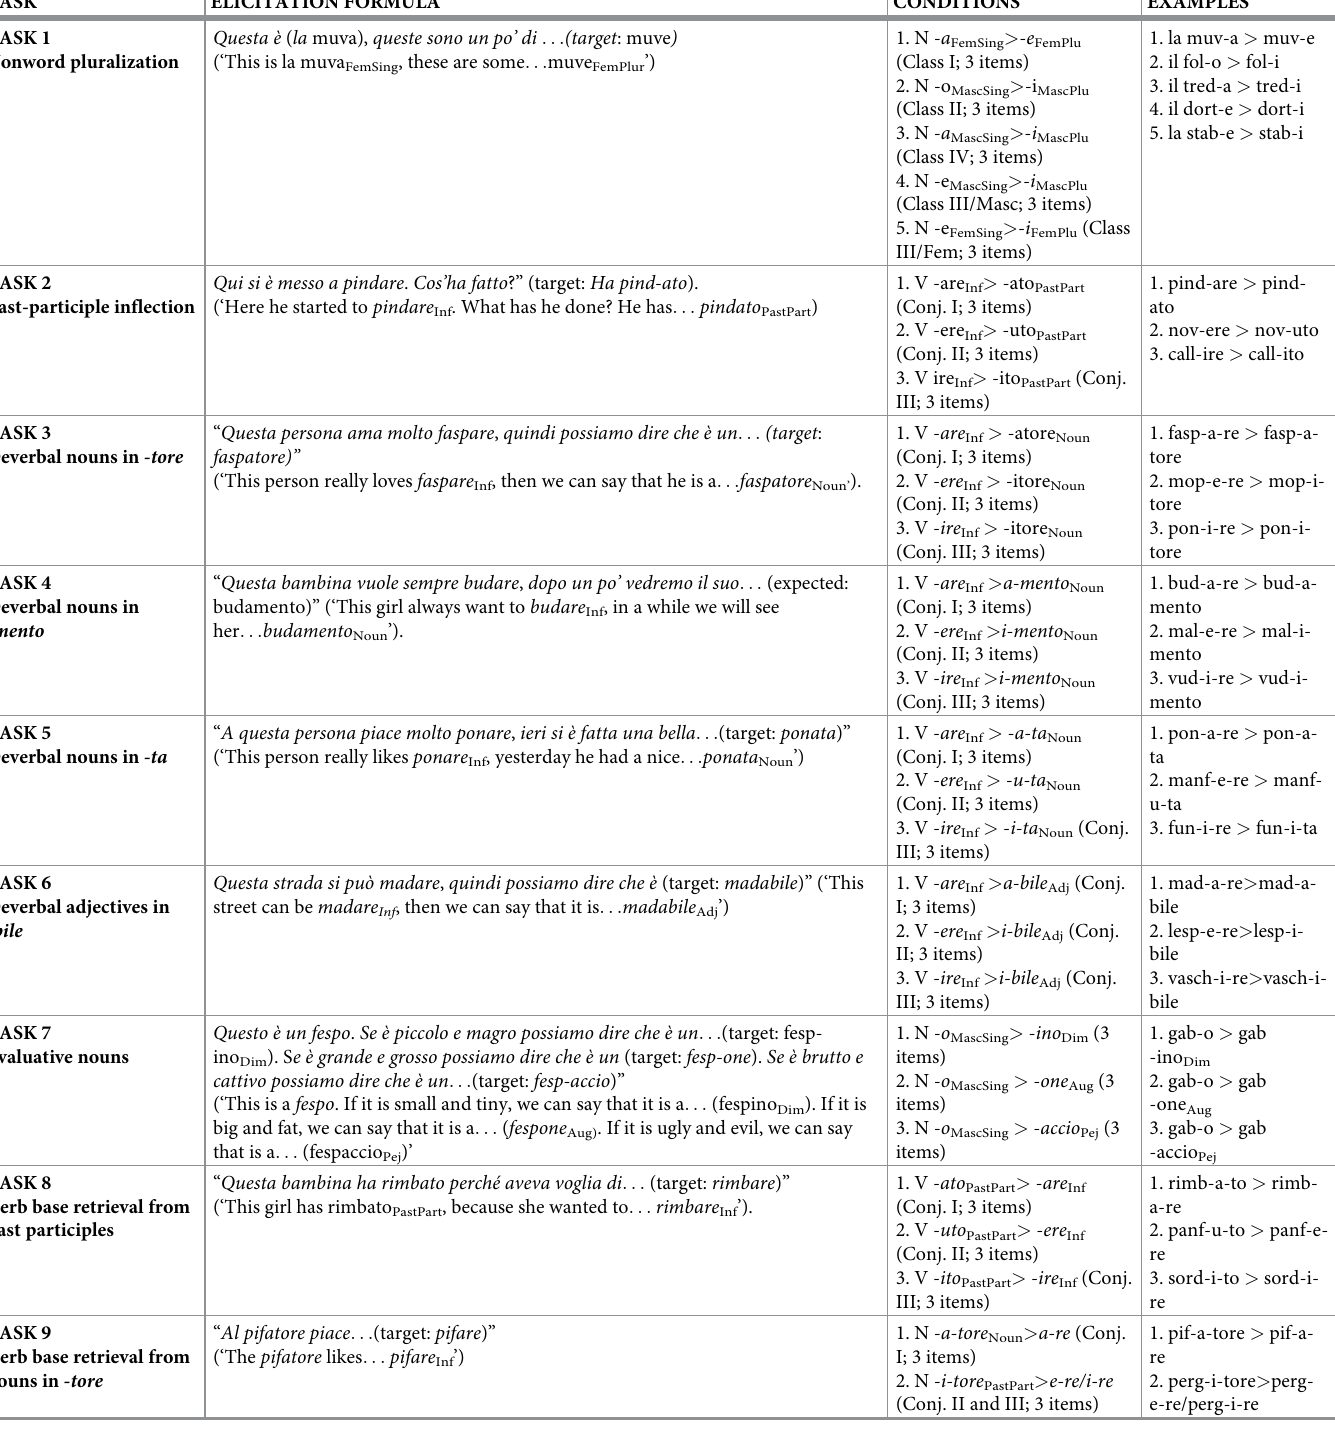
Table 5. The tasks: Elicitation formula, conditions, and